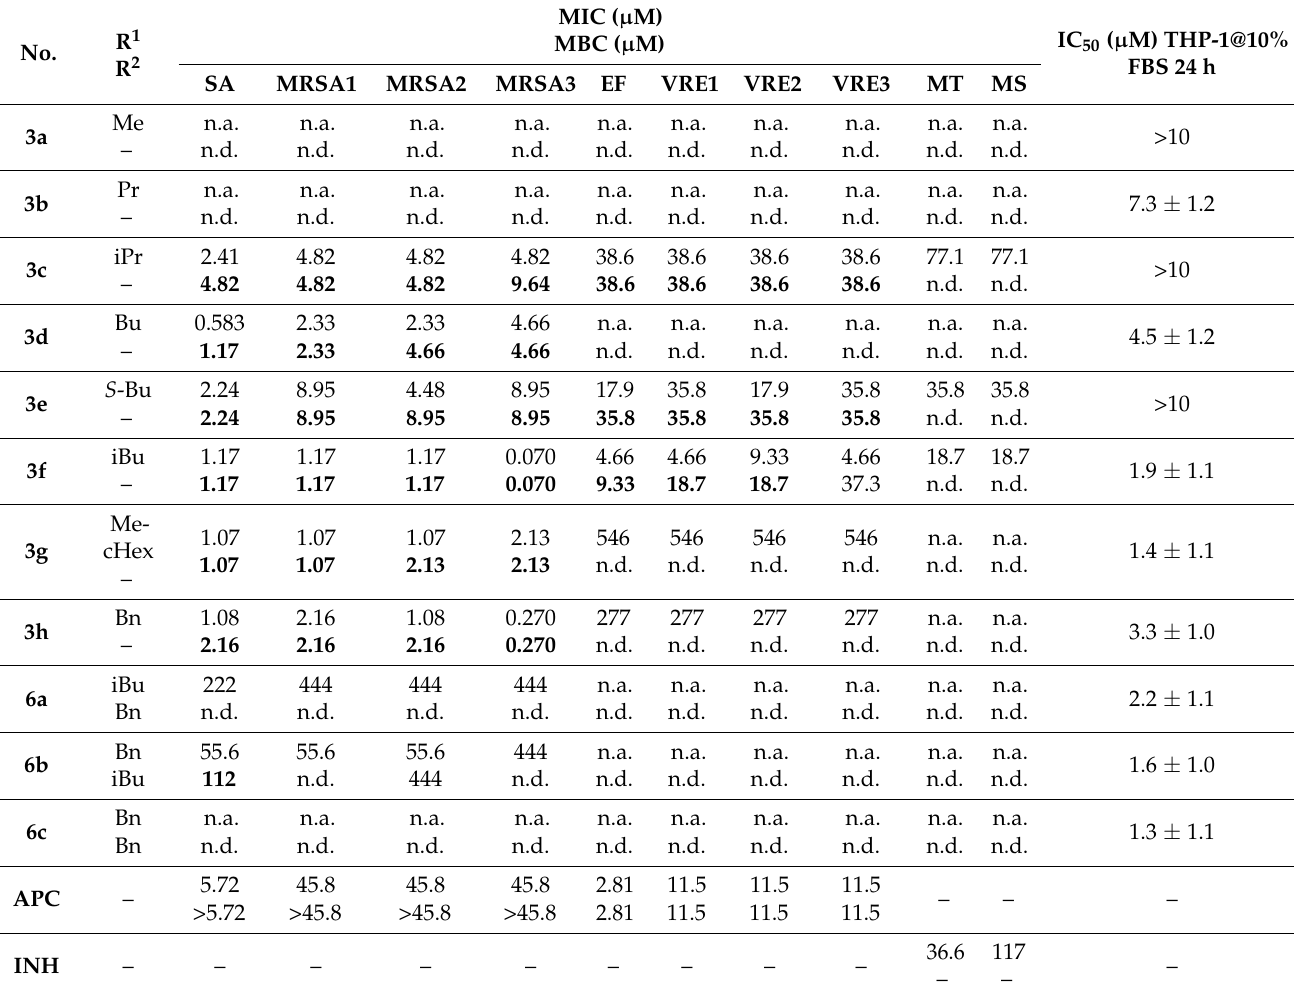
Table 2. In vitro antistaphylococcal, anti-enterococcal, and antimycobacterial activities (MIC/MBC ( µ M)) compared to ampicillin (APC), isoniazid (INH), and in vitro cell viability (IC 50 ( µ M) ± SD, n = 6) on human monocytic leukemia cell line